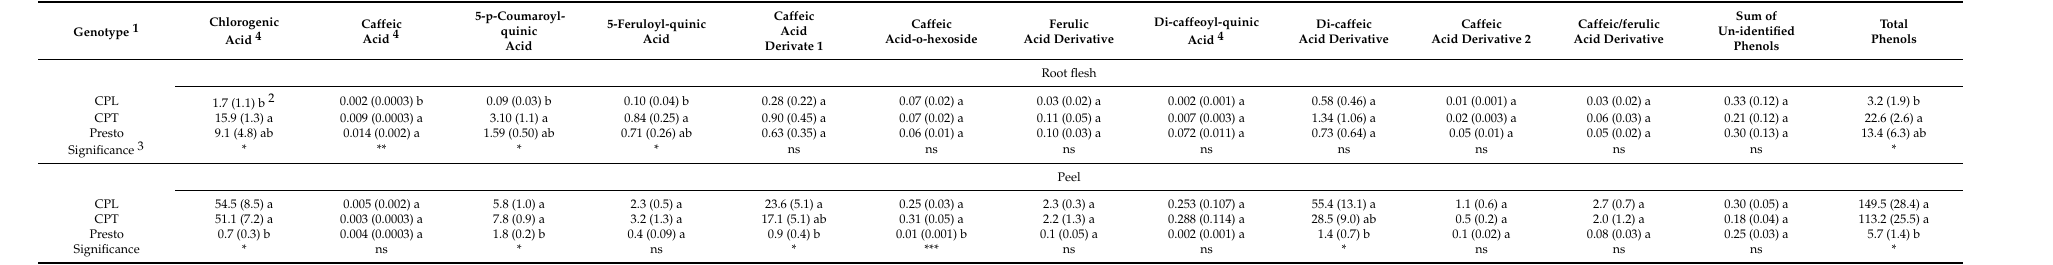
Table 6. Concentration of phenolic compounds in the root flesh and peel of carrot genotypes (mg kg − 1